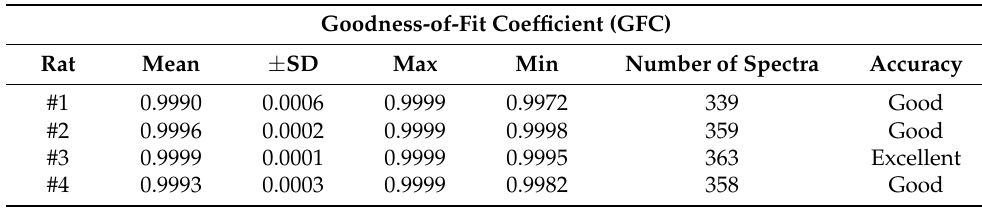
Table 1. Goodness-of-fit coefficient (GFC) obtained from four rats during methemoglobinemia. Goodness-of-Fit Coefficient (GFC)